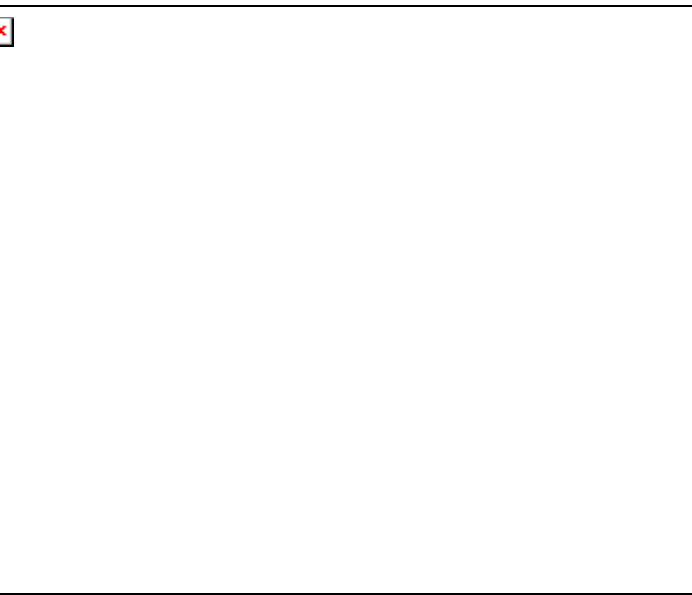
, a as a function of JPD is also presented (R 2 (a x y